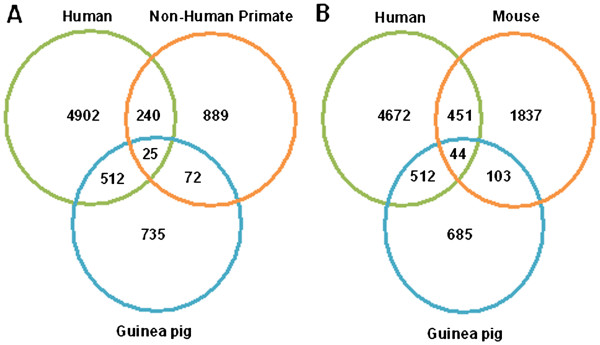
 Comparison of transcriptional response of guinea pig, human, non-human primate and mouse to M. tuberculosis infection. The Venn diagrams depict the degree of overlap between up regulated genes of (A) Guinea pig, human and non-human primates and (B) Guinea pig, human and mouse. The analysis included comparison of the list of differentials obtained from our study with that obtained from various microarray data available in the public database for TB infection in case of; human [GEO Accession no. GSE20050], mouse [GEO Accession no. GSE15335] and non-human primate [GEO Accession no. GPL10183]. Down regulated genes did not show any considerable overlap across the species, hence not depicted in the figure.